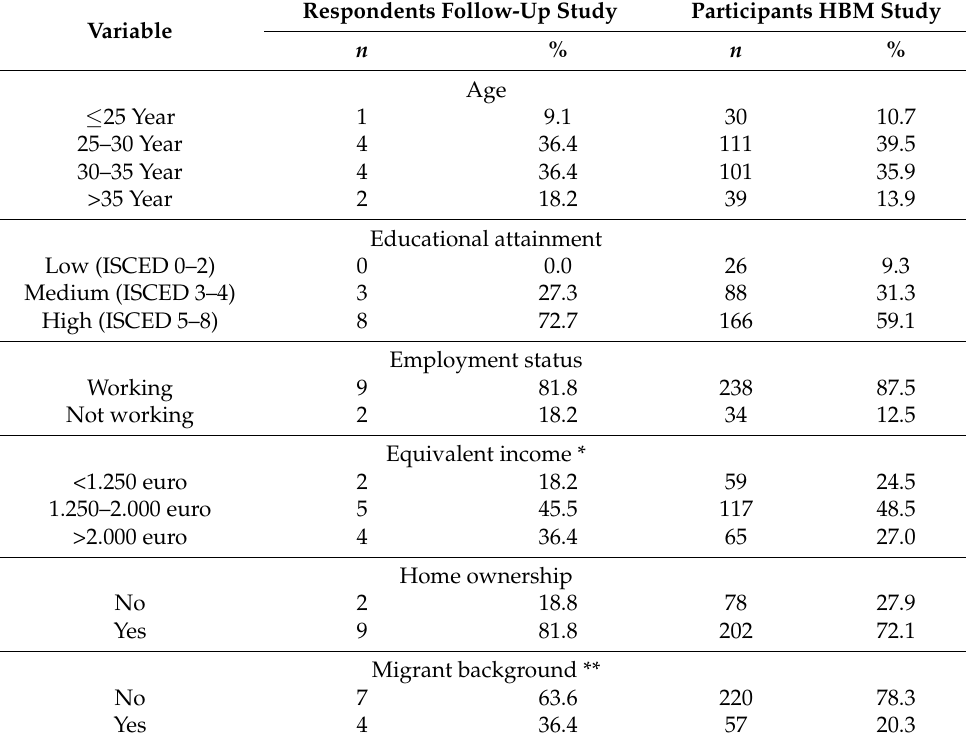
Table 3. Demographic and socioeconomic characteristics of respondents.